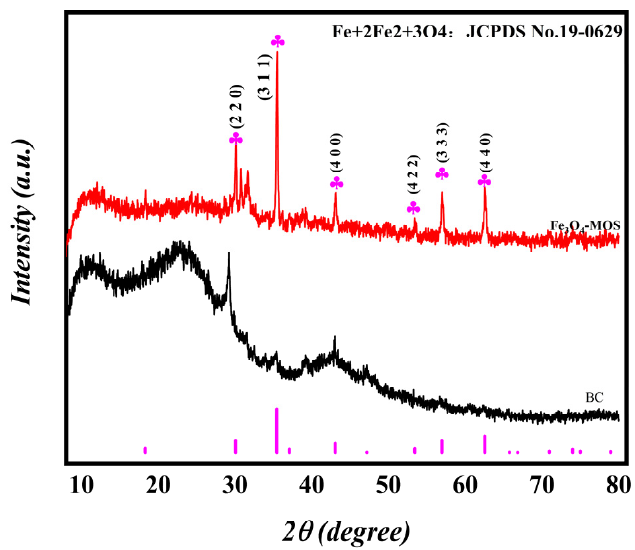
Figure 2. XRD patterns for biochar and magnetic moringa seed shell